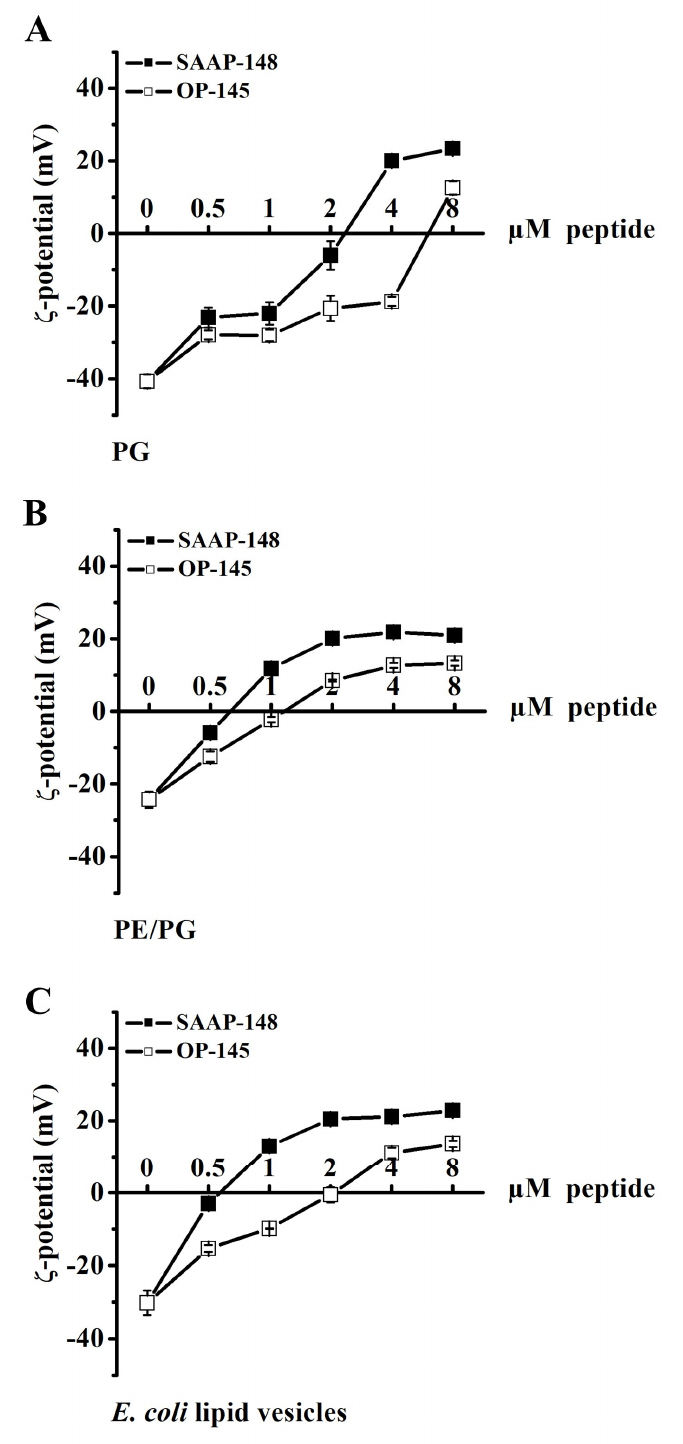
Figure 5. Zeta potential measurements of membranes PG ( A ), PE/PG ( B ), and E. coli polar lipids ( C ) in absence and presence of OP-145 (empty squares) and SAAP-148 (filled squares) at indicated concentra- tion ranging from 0.5 to 8 µ M for membrane model which corresponds to lipid to peptide molar ratio of 100:1-6.25:1. Data points are averages ± standard deviations of three independent